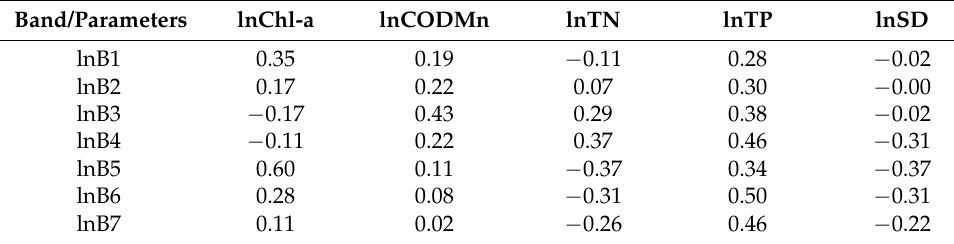
Table 5. The correlation matrix between band reflectance and water quality parameter. Band/Parameters